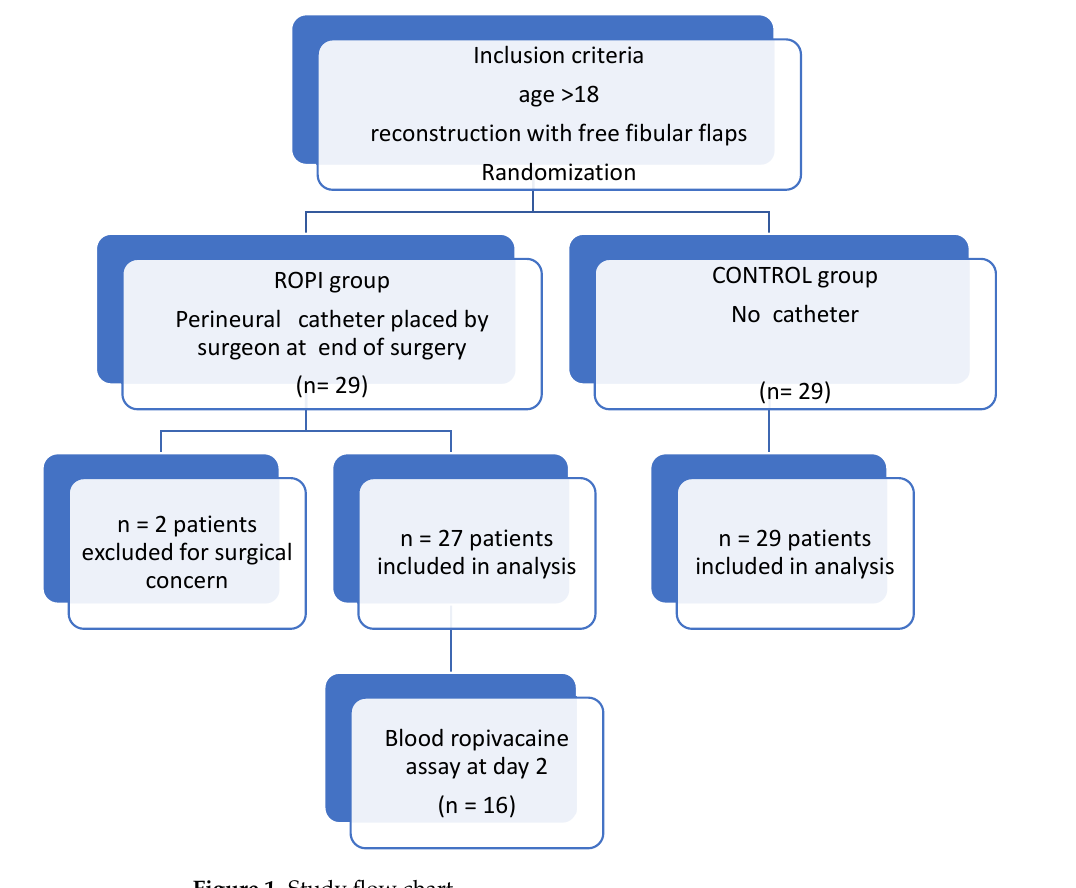
Figure 1. Study flow chart. Table 1. Demographic and perioperative data (M ±